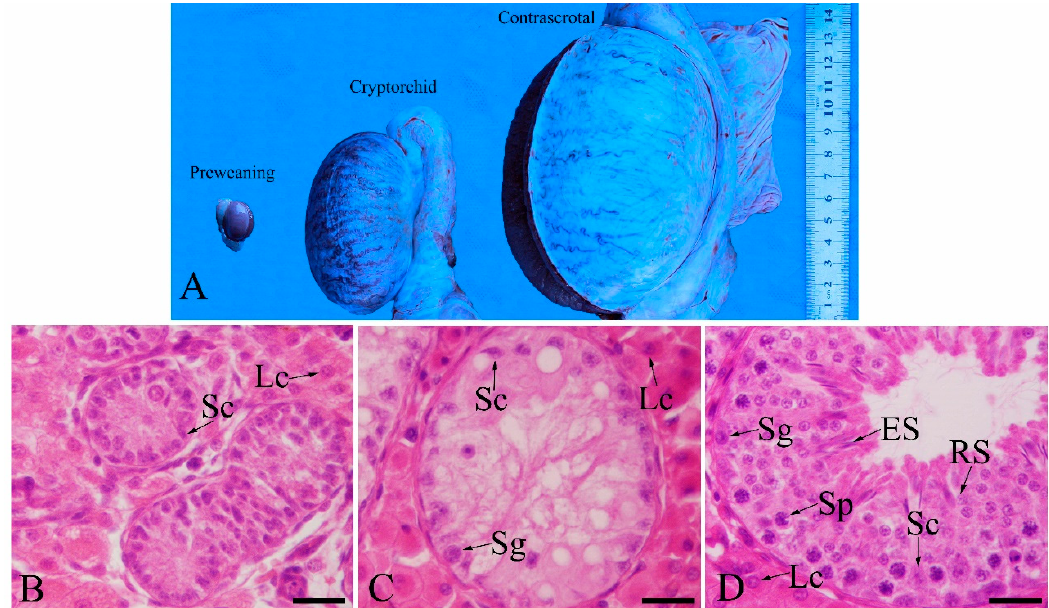
Figure 1. Testicular sizes and HE staining of boar testes. Testicular sizes, preweaning testes, cryptorchid testes, and contrascrotal testes ( A – D ). Sg, spermatogonia; Sp, spermatocyte; RS, round spermatid; ES, elongated spermatid; Sc, Sertoli cell; Lc, Leydig cell. Bar = 25 μ m.